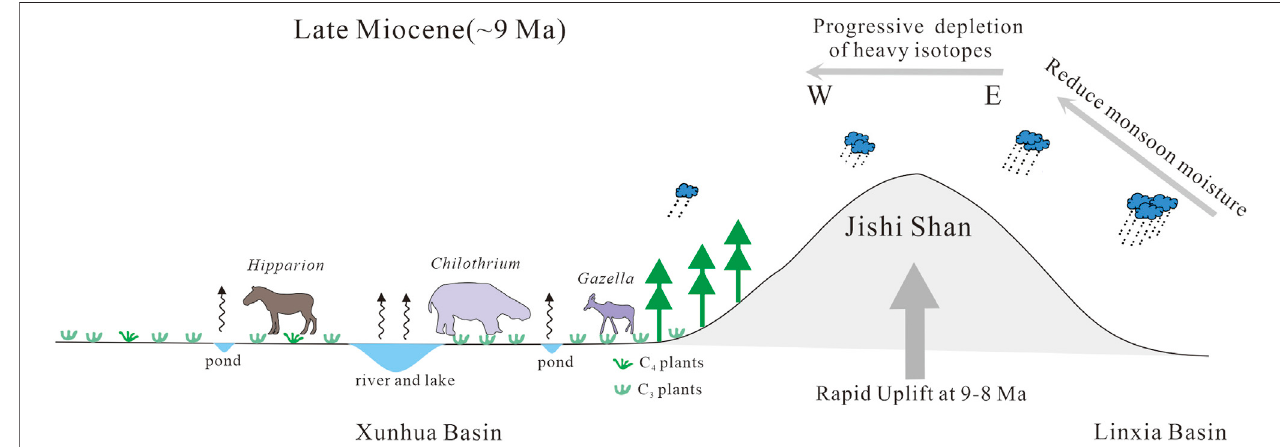
FIGURE 9 | Sketch map illustrating the paleoecological characteristics of the Xunhua Basin in the northeastern Tibetan Plateau at ∼ 9 Ma.